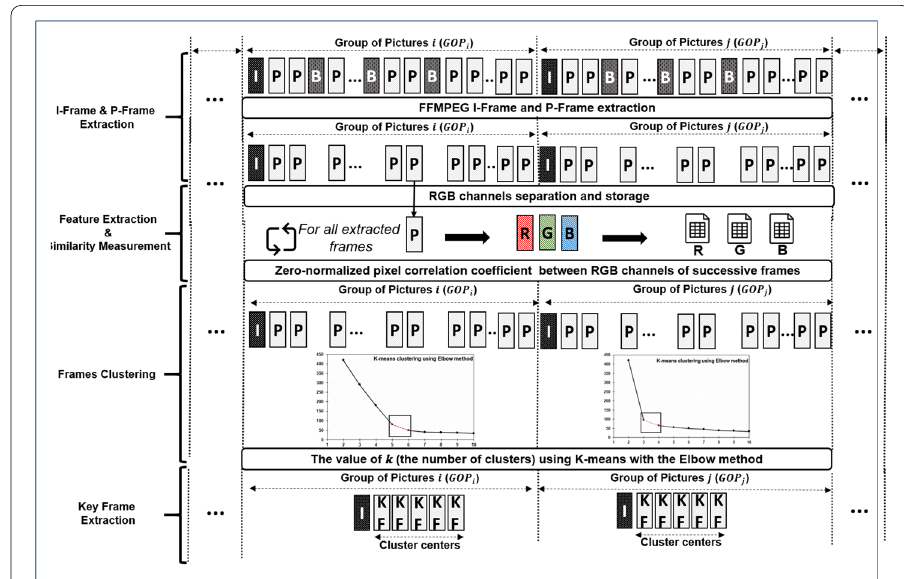
Fig. 3 The key frame extraction method